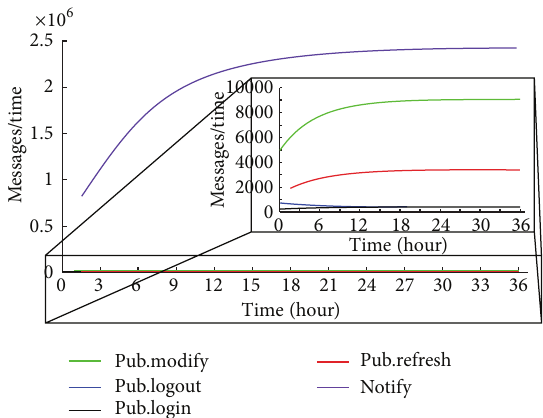
Figure 8: Messages in system B.